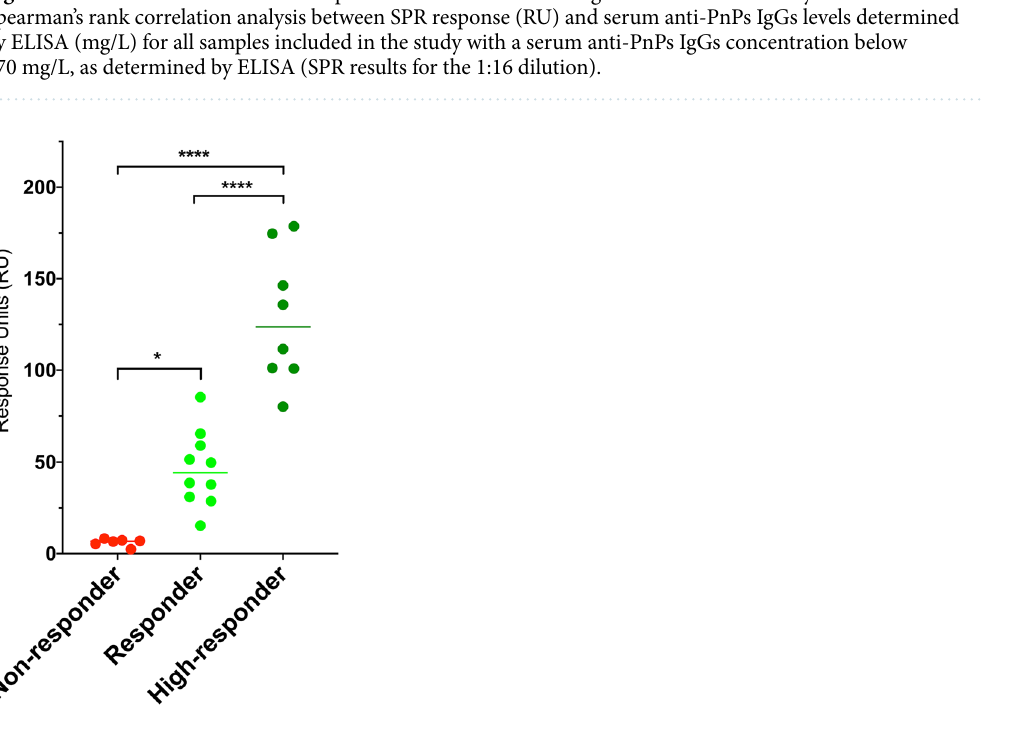
Figure 6. SPR binding profile reflects subjects’ immunization state. Dot plots showing the SPR binding level (1:16 dilution) in the samples included in the study, classified according to their PCV13 response profile, determined by ELISA: Non-responder (red), Responder (light green), High-responder (dark green). Student’s t-test: * p value < 0.05; **** p value <